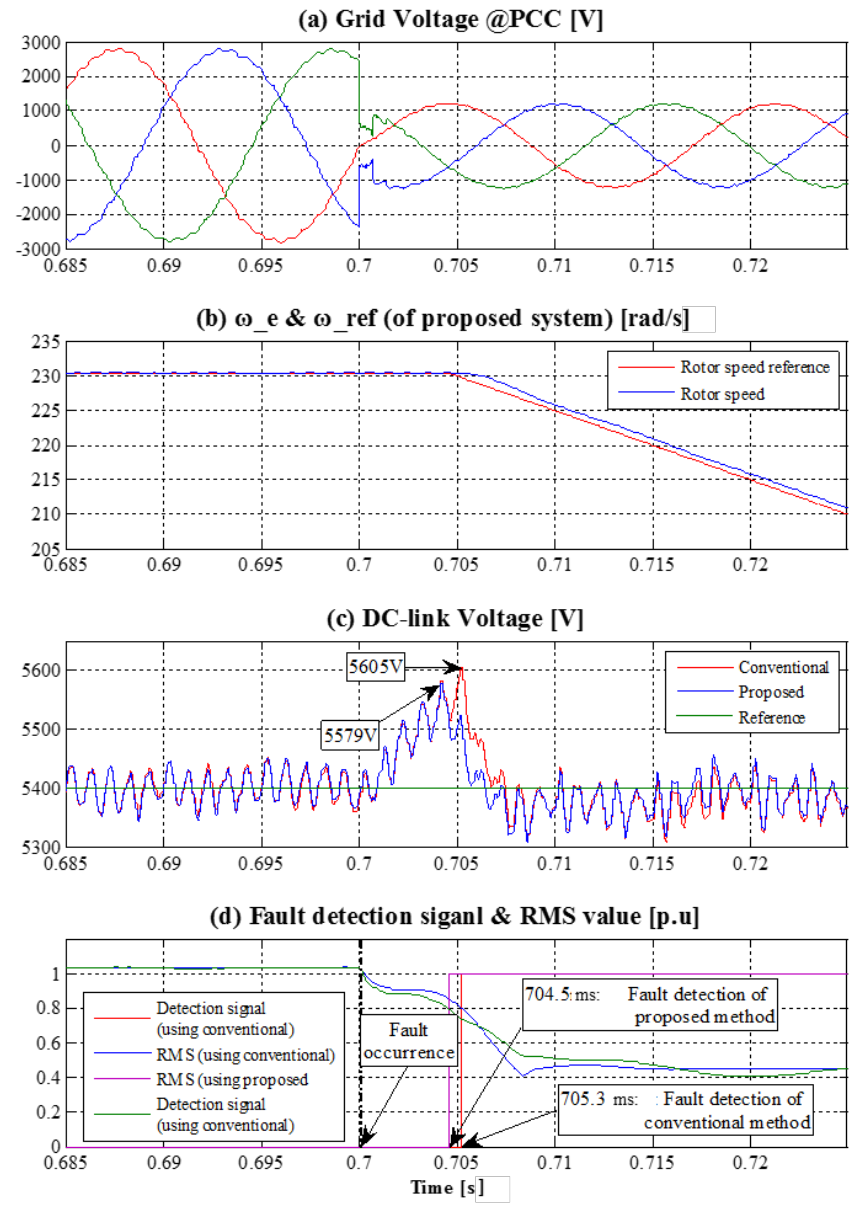
Figure 10. Simulation results of Case 1: ( a ) grid voltage waveforms; ( b ) the rotor speed of the PMSG; ( c ) DC-link voltage of the full-scale inverter; and ( d ) fault detection according to the measure RMS